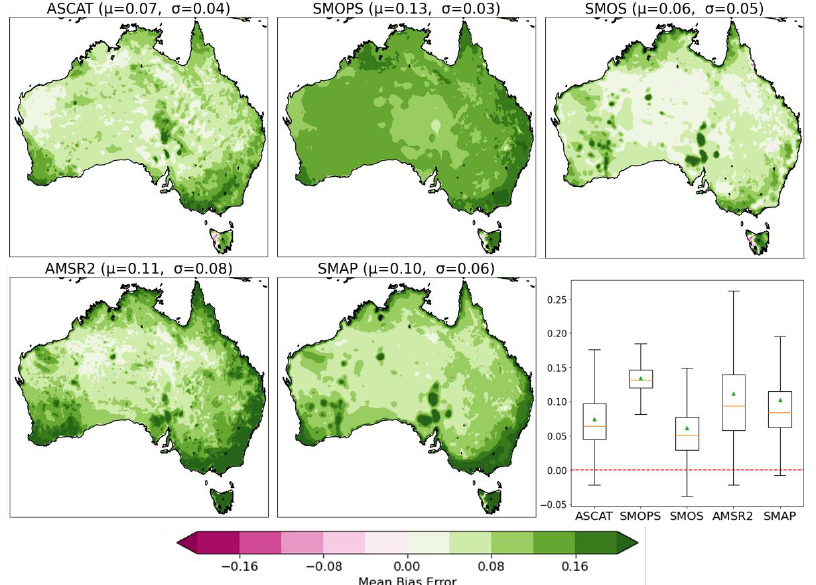
Figure 6. Temporal MBE results depicted spatially for ASCAT, SMOPS, SMOS, AMSR-2, and SMAP. An accompanying box-whisker plot depicts the spatio-temporal results — whiskers extend out to show the interquartile range, the orange line indicates the distribution median, and the green triangle indicates the distribution mean, red dashed line indicates perfect value. Similarly, for MAE (Figure 7) and RMSE (Figure 8), we find that AWRA-L average errors are similar in magnitude to average errors from the point-based analysis. Similar to MBE, SMOPS has the largest mean MAE and RMSE over Australia, and for AMSR-2, we note large MAE values over the south-eastern coast and southern Tasmania. For SMOS and ASCAT, there are also bullseye regions with high MAE values close to the Lake Eyre region of South Australia.